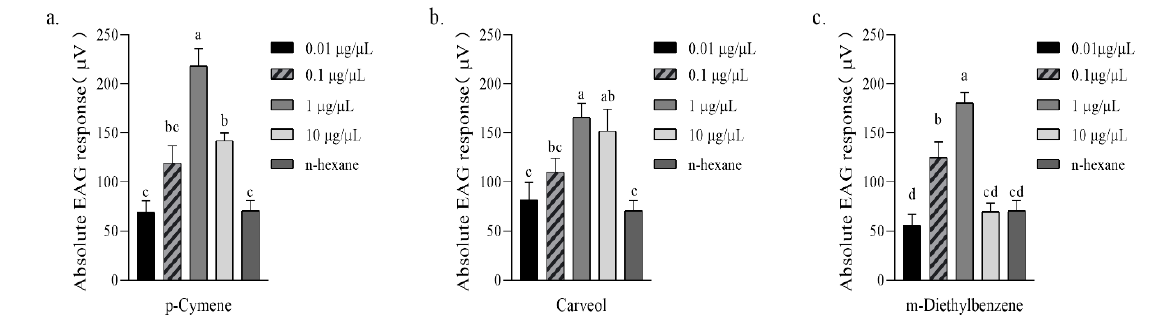
Figure 6. Absolute EAG response [mean ± SE ( μ V), n = 6] of female Aphidius gifuensis antenna to 10 μ L of synthetic chemical. ( a ) P-cymene, ( b ) Carveol, ( c ) M-Diethylbenzenel. Different letters indicate indicate that values differ statistically at p < 0.05 (ANOVA, followed by LSD test). that values differ statistically at p < 0.05 (ANOVA, followed by LSD test).